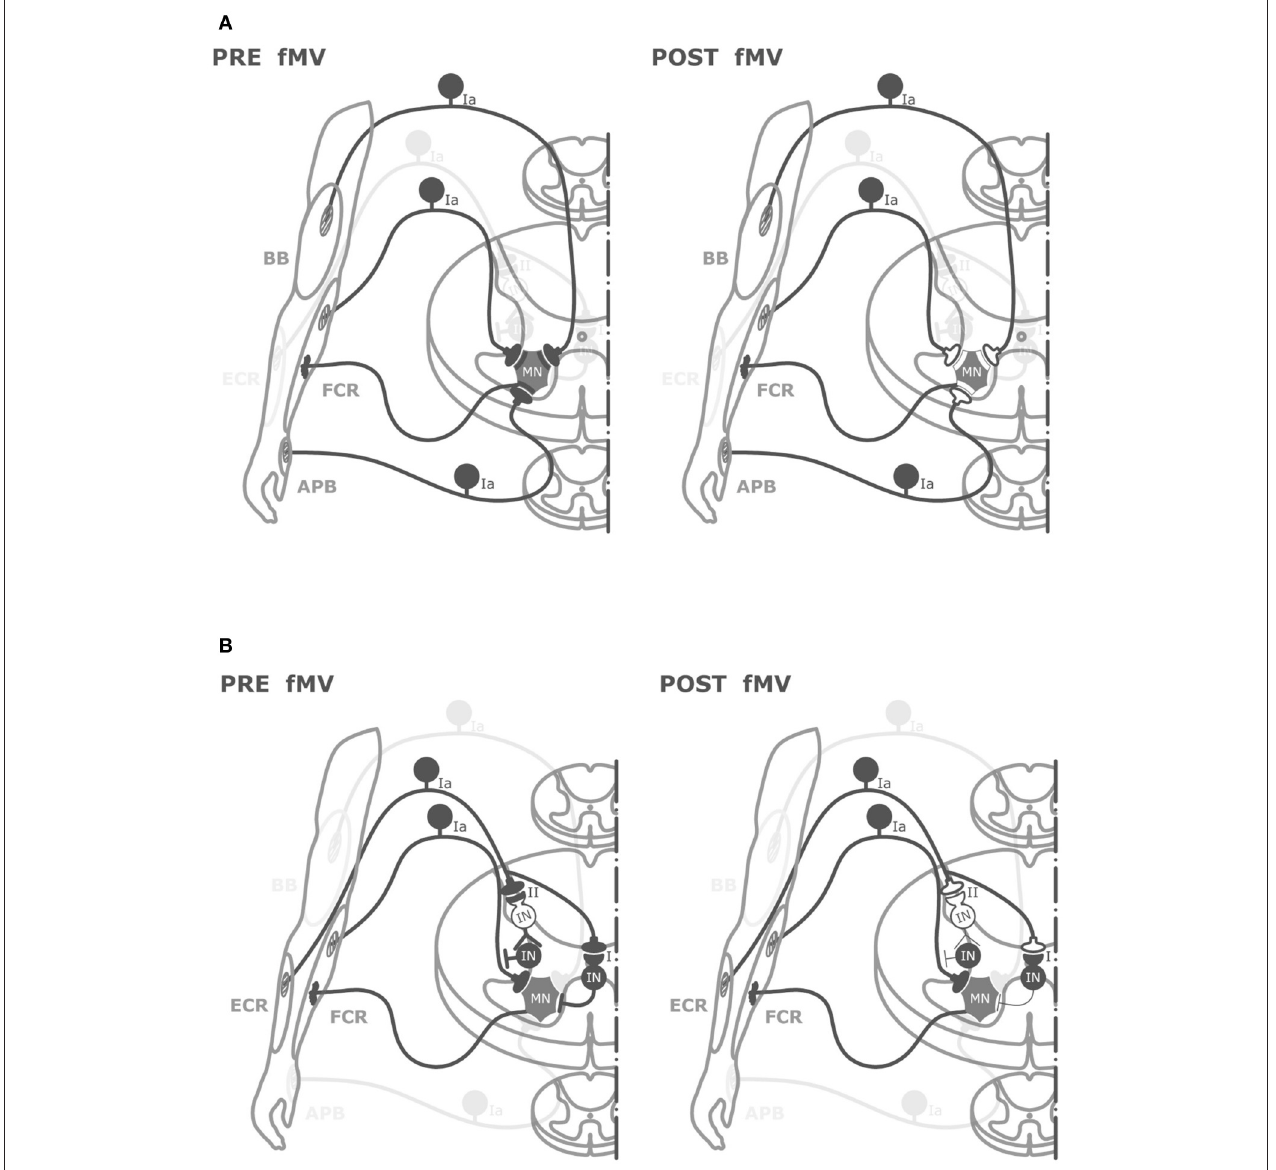
FIGURE 5 | Graphical representation of putative spinal circuits responsible for fMV-induced after effects on HR and RI. (A) Spinal circuits modulated by FCR-, BB-, and APB-fMV. Ia afferents from FCR, BB, and APB muscle spindles have homonymous and heteronymous connections (black synaptic boutons) with α -motoneurons (MNs) innervating the FCR muscle. fMV applied over FCR, BB and APB produces a long-term decrease in HR amplitude through a synaptic LTD-like mechanism (white synaptic boutons). (B) Spinal circuits modulated by fMV applied over the ECR muscle. fMV induces a form of long-term inhibitory plasticity at the synapse between Ia afferents from ECR and Ia inhibitory interneurons (black circle) mediating the first phase of RI (I), and between Ia afferent and the excitatory interneuron (white circle) in the proximal part of the chain responsible for the second phase of RI